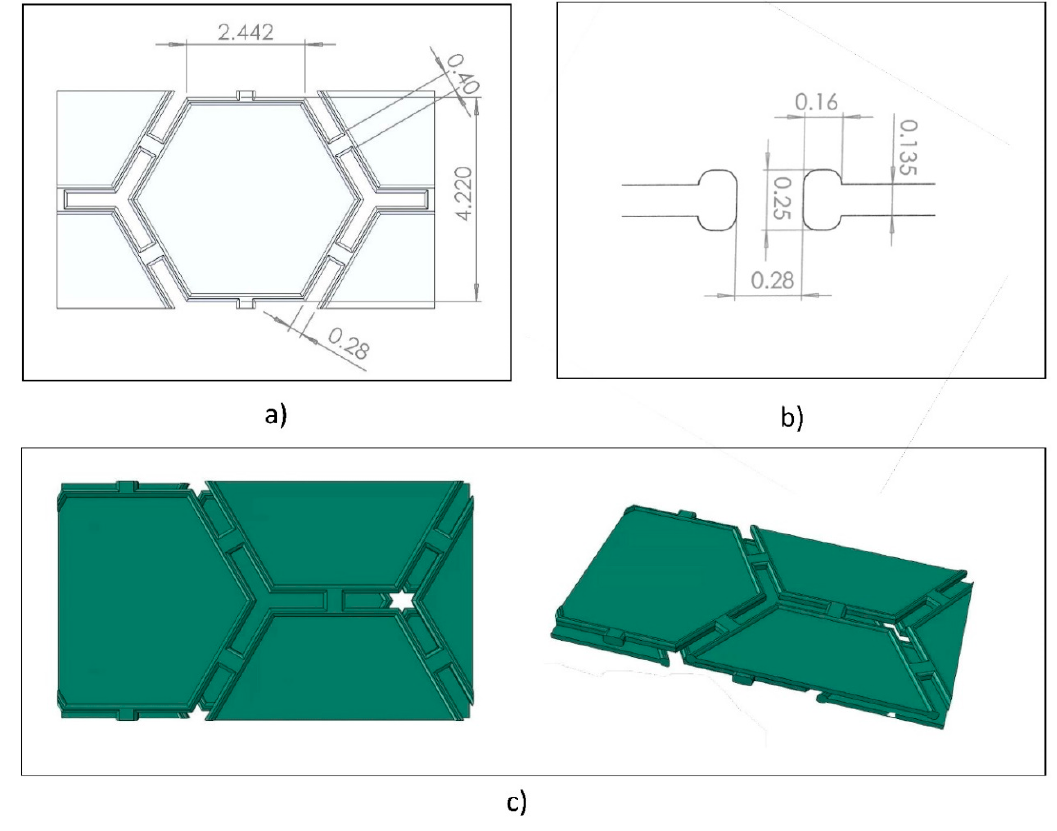
Figure 2. Measured and drawn geometry of the laminated polystyrene plates. ( a ) Tablet dimensions, ( b ) Bulge section view with dimensions. ( c ) Representative volume element (RVE) CAD model representing polystyrene cut tablets.